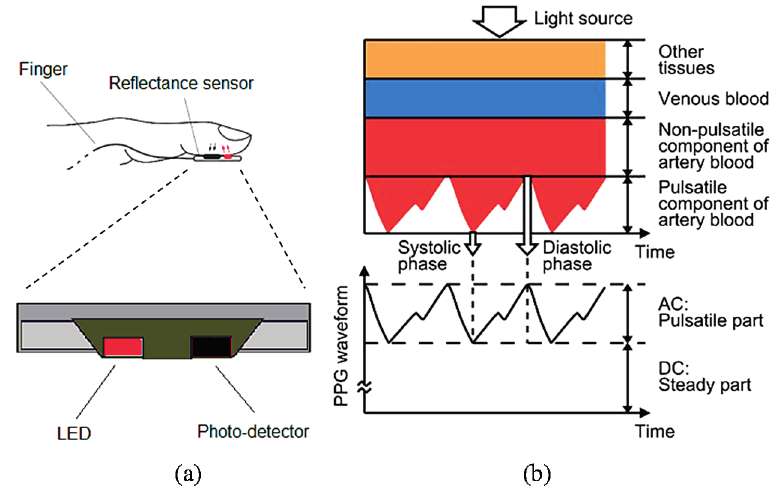
Figure 1. Illustrated diagram of the reflectance sensor ( a ) and the light absorbance of tissue components ( b ) (revisited and modified from